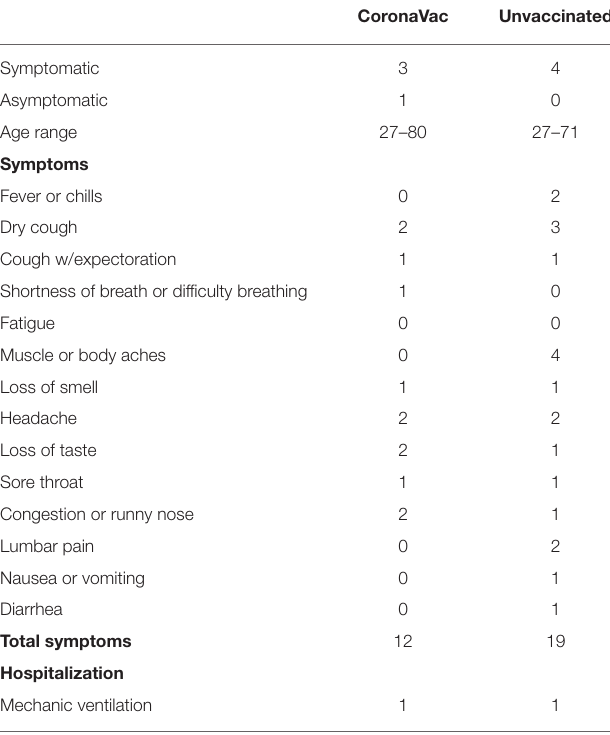
TABLE 1 | Summary of symptom prevalence and severity in CoronaVac vaccinated and unvaccinated patients (n ◦ ).